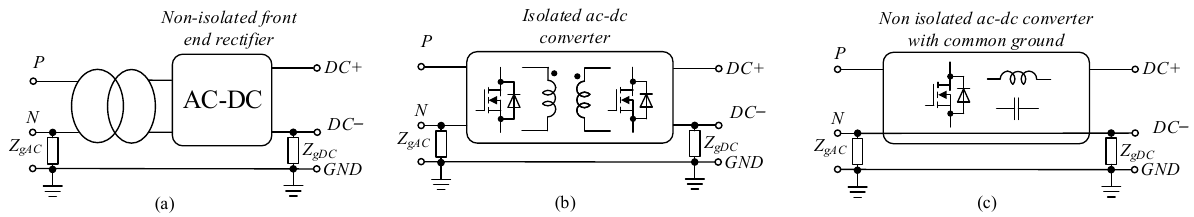
Figure 2. Schematics of existing solutions for power flow between AC and DC microgrids: ( a ) non- isolated front-end rectifier, ( b ) isolated ac-DC converter, and ( c ) non-isolated power converters with common-ground architecture.